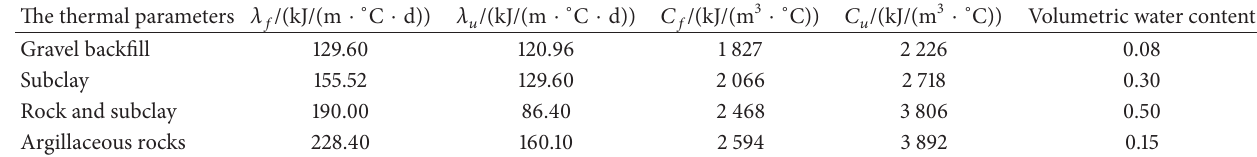
Table 5: Soil parameters used in finite element analysis.